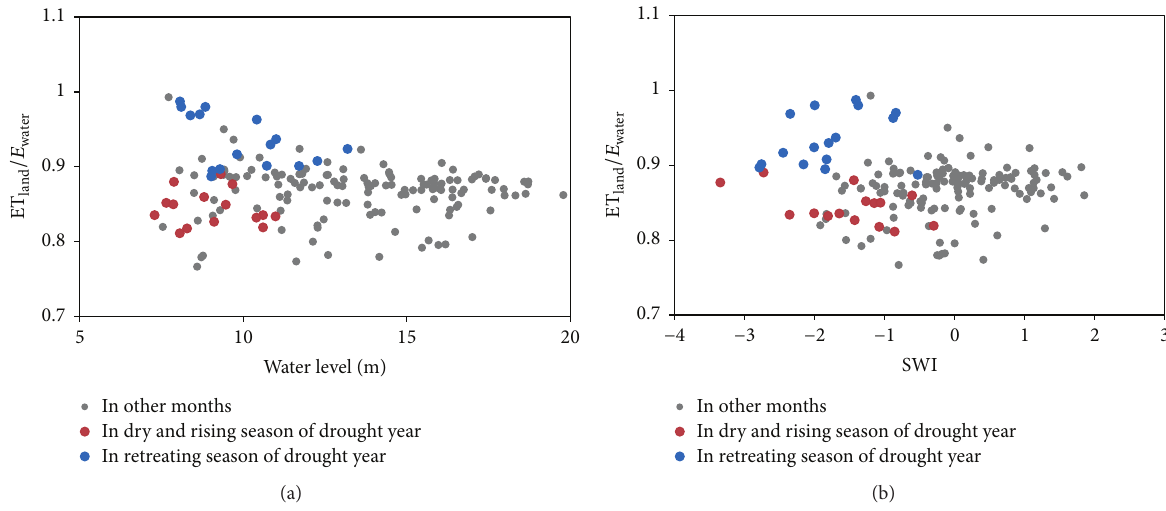
Figure 7: The relationship between the monthly ET land / 𝐸 water and both (a) the water level and (b) the SWI.